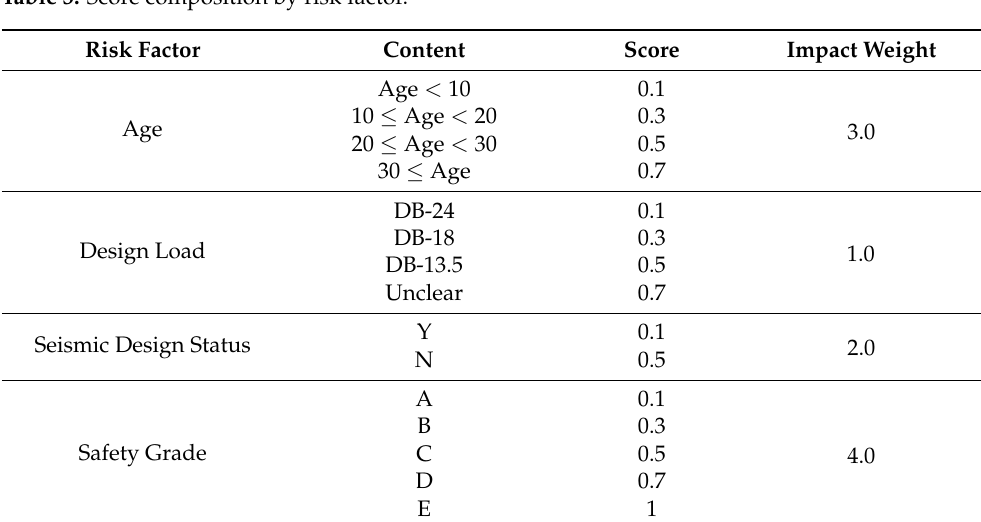
Table 3. Score composition by risk